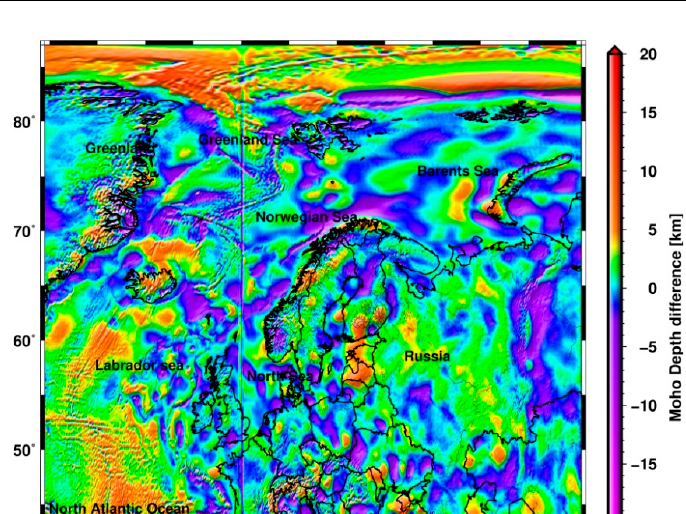
Figure 5. The Moho depth differences between ( a ) the HRCM Butterworth filter solution and the Eurasian Moho model [5] and ( b ) the HRCM spectral combination solution and the Eurasian Moho model [5]. Unit: km.